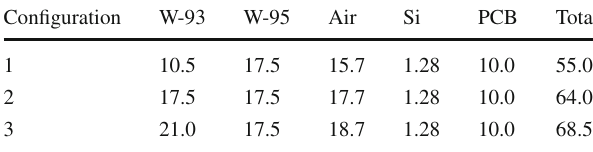
Table 2 Summary of the total thickness in mm along the Z axis of the different components in the stack, for the different configurations